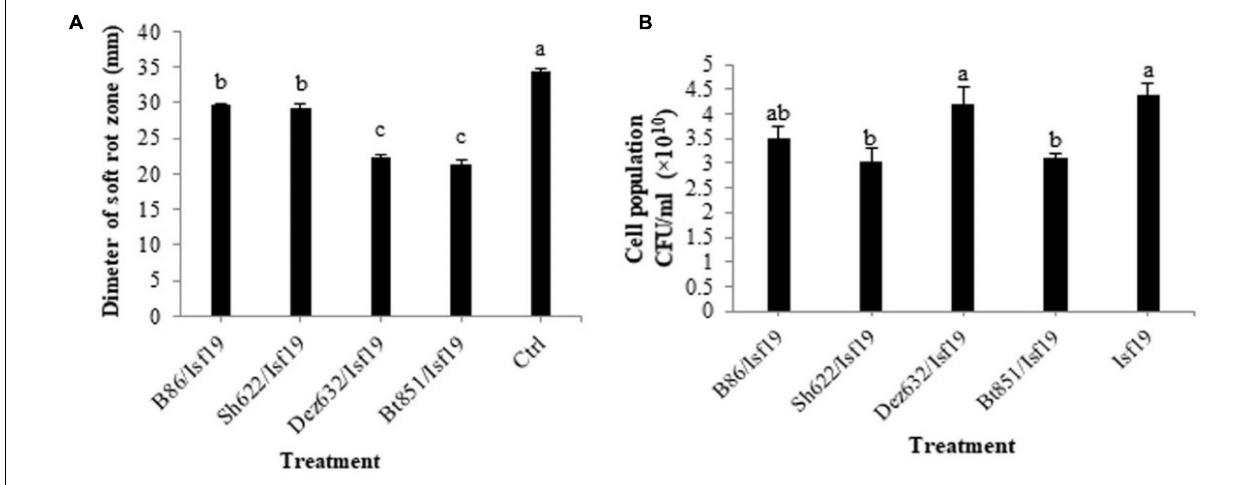
**Significant at 5% probability level.